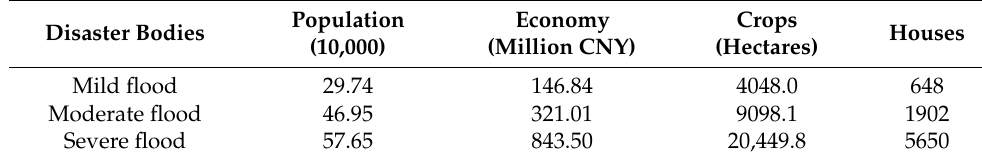
Table 8. Socioeconomic risks of different floods in Cangnan County.